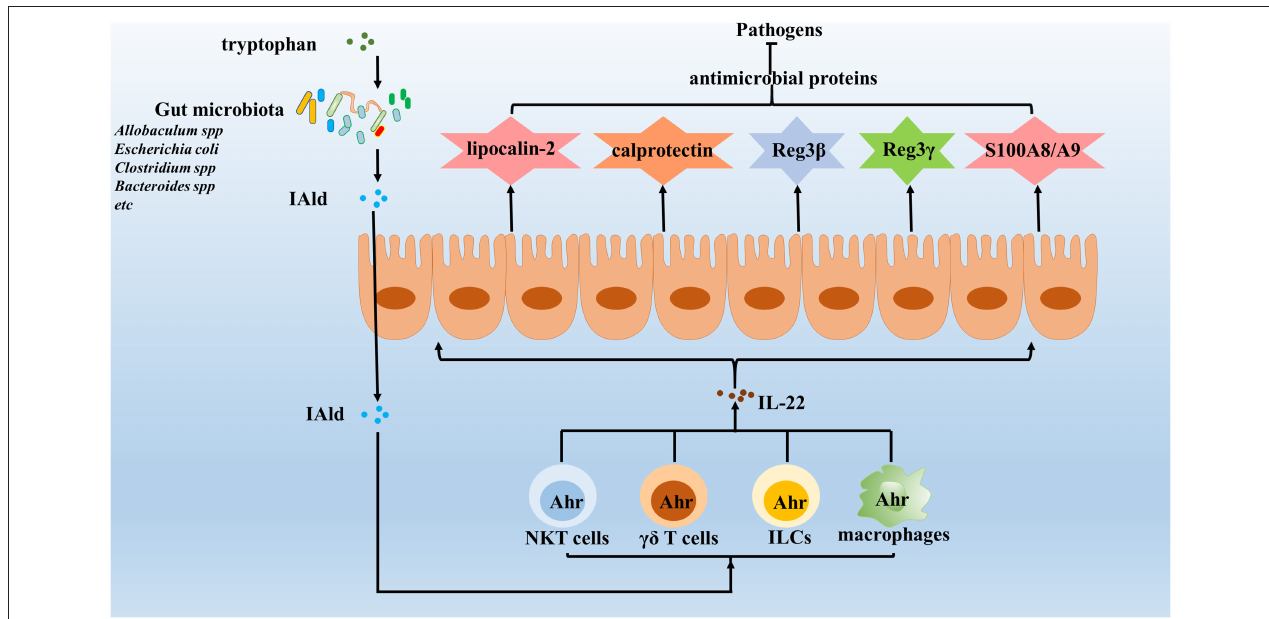
FIGURE 2 | Gut microbiota enhance the expression of IL-22 against invading pathogens. IL-22 is important in maintaining the integrity of mucosal barriers and can be produced by many different types innate immune cells, which induce the expression of various antimicrobial proteins, including lipocalin-2, calprotectin, C-type lectins, S100A8, S100A9, and so on to clear pathogens. Increasing evidence identified that gut microbiota enhances the expression of IL-22 to protect the host against pathogens. The results show that gut microbiota utilize tryptophan as an energy source and produce a metabolite, indole-3-aldehyde (IAld), which in turns activated Ahr on innate immune cells. Once activated, innate immune cells will secrete IL-22, which protects the host against opportunistic pathogens by reducing their